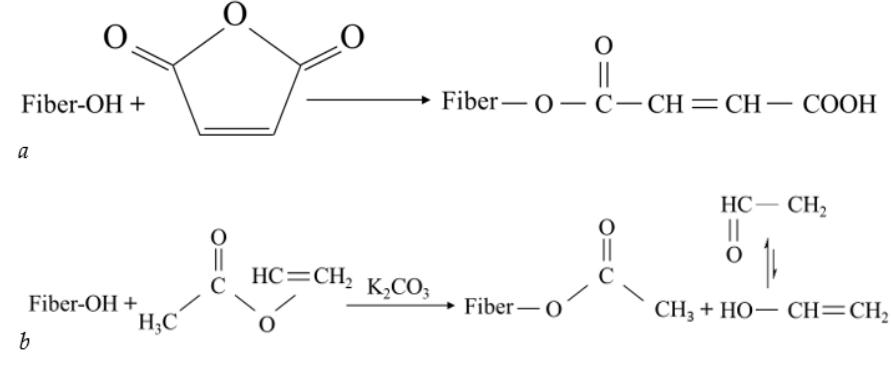
Figure 3. Grafted cellulose with ( a ) maleic anhydride and ( b ) vinyl